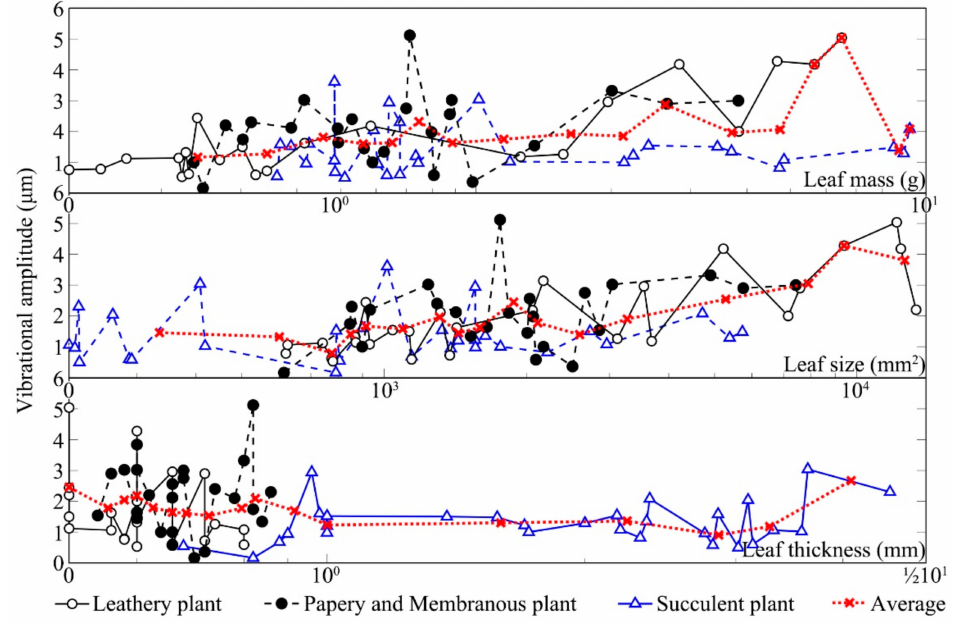
Figure 6. Vibrational amplitudes of three di ff erent kinds of textures. Table 3. Kendall correlation coe ffi cients between the increase in plant leaf vibrational amplitude and leaf physical properties. Leaf Texture P / N Factor All Plants Leathery Papery and